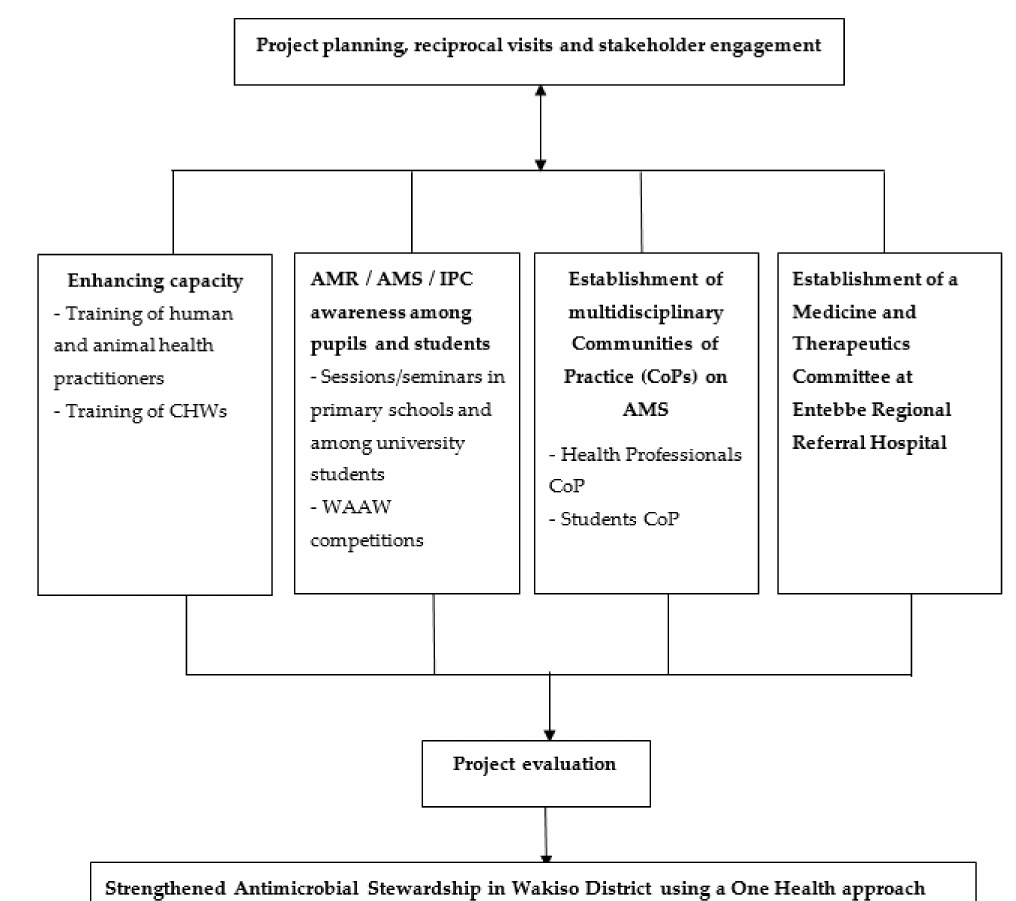
Figure 1. Summary of the project